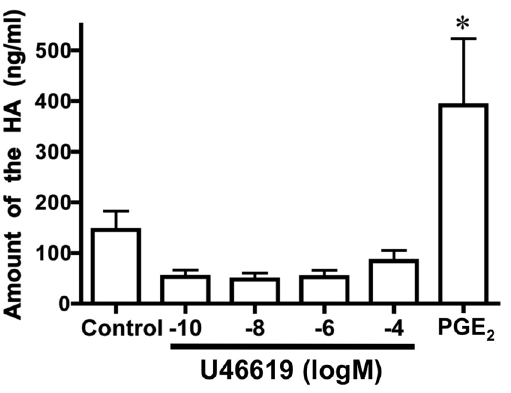
Figure 5. TP stimulation did not promote hyaluronan produc- tion. The amount of hyaluronan (HA) in the supernatant from the cultured DA SMCs. Values are expressed as the mean 6 SEM. n=4. * indicates p , 0.01 versus control.